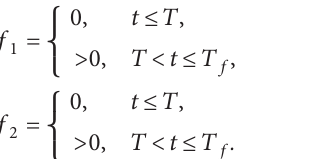
, and I for 0% and 100% implementation of controls (in this case, R 1 2